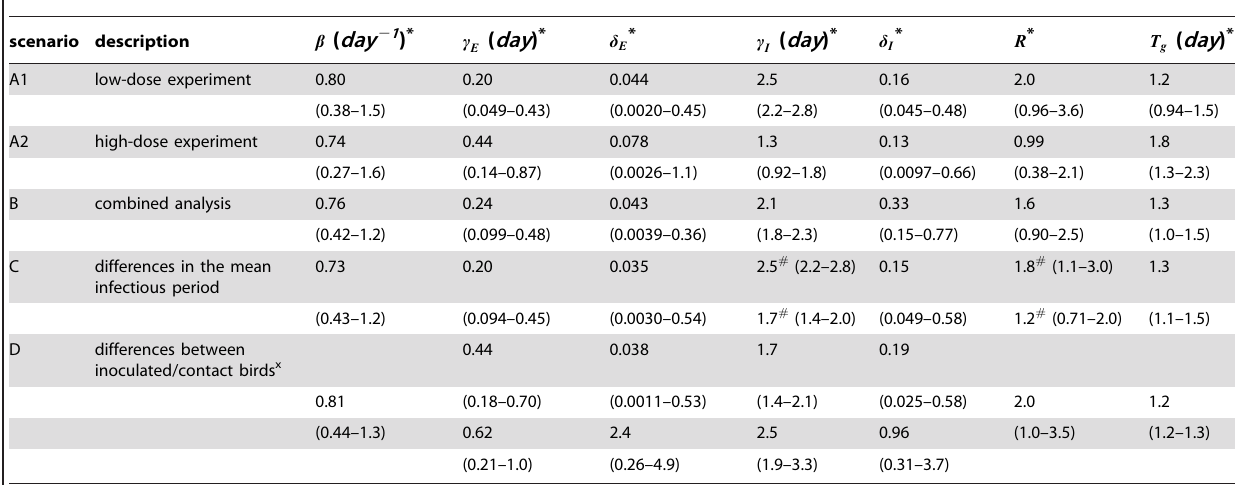
Table 4. Overview of the Bayesian